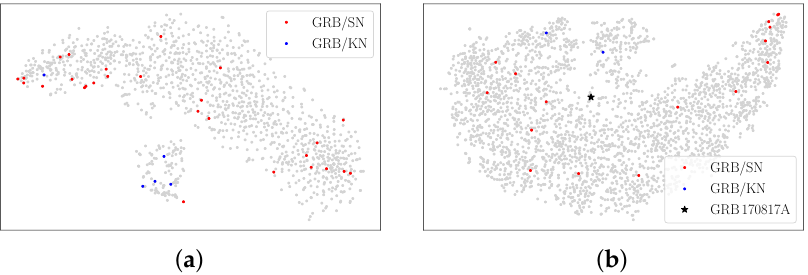
Figure 9. Locations of GRBs with associated Supernovae (GRB/SN) and possible Kilonovae (GRB/KN) within the t-SNE projections of the T 1 interval for ( a ) Swift /BAT and ( b ) Fermi /GBM. The location of the only confirmed kilonova, associated with GRB170817A, is indicated with a black